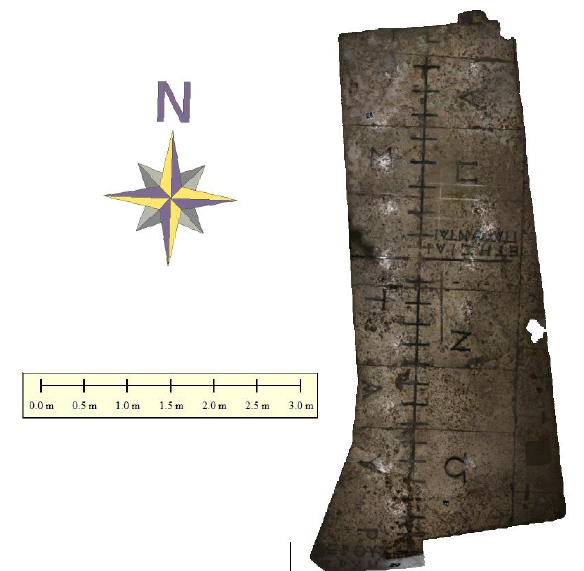
Figure 2. Part of the pavement of the meridian line located in “Via Campo Marzio”